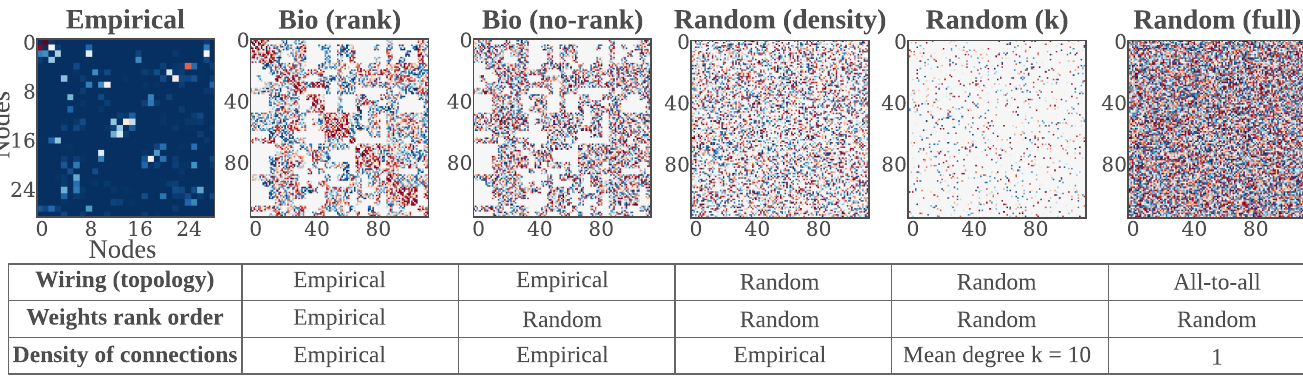
Fig 2. bio2art , scaling up connectivity and surrogates. The connectivity of the networks derived from the empirical connectivity and used as reservoirs in the BioESNs can be represented as an adjacency matrix. This figure shows examples of adjacency matrices representing a scaled up version (4x) of the Macaque monkey empirical brain connectivity then integrated into the BioESN as reservoir. We also build surrogate connectivities for comparison with the empirical case that preserves real connectivity patterns. Each surrogate network controls for different aspects of the connectivity, as shown in the summary table in the figure. The figure depicts an example of the empirical (Macaque) connectivity and the different derived connectivities tested. Notice the nodes indices, explicitly showing the upscaling of the connectivity. This was repeated for all the other connectomes tested. See Mapping and upscaling connectomes with bio2art for more details on connectivity generation and